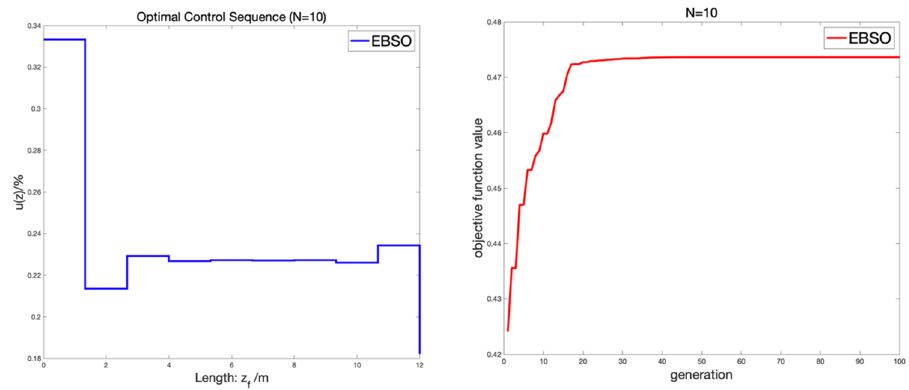
Figure 29. Optimal control trajectory and iteration curve ( N = 10).